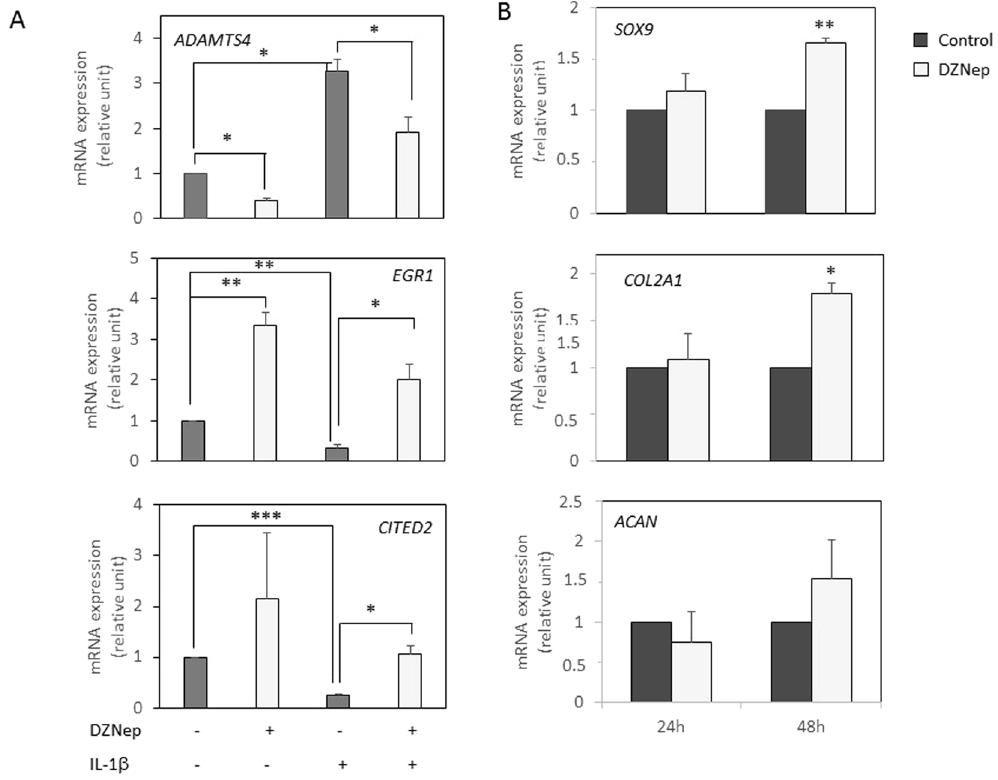
Figure 6. DZNep upregulated COL2A1 and SOX9 expression. Primary chondrocytes were treated or not with DZNep (1 µ M) in the presence or absence of IL-1 β (1 ng/mL) for 24 h ( A ), or in the absence of IL-1 β (1 ng/ mL) for 24 h or 48 h ( B ). After treatments, mRNA were extracted, and relative gene expression was determined by real-time RT-PCR, using GAPDH expression as reference. Data are expressed as means ± SEM. Statistical significance are represented. * p-value ≤ 0.05, ** p-value ≤ 0.01., *** p-value ≤